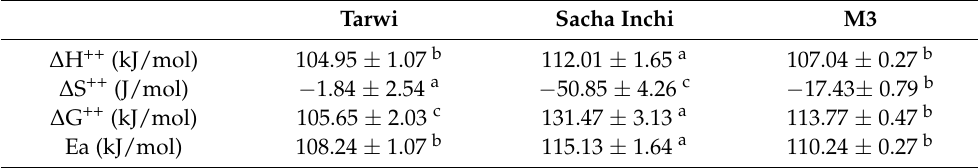
Table 3. Thermodynamics values (mean ± SD) for enthalpy ( ∆ H ++ ), entropy ( ∆ S ++ ), Gibbs free energy ( ∆ G ++ ) and activation energy (Ea) of tarwi oil, sacha inchi oil and their 1:1 blend (M3). Tarwi Sacha Inchi M3 ∆ H ++